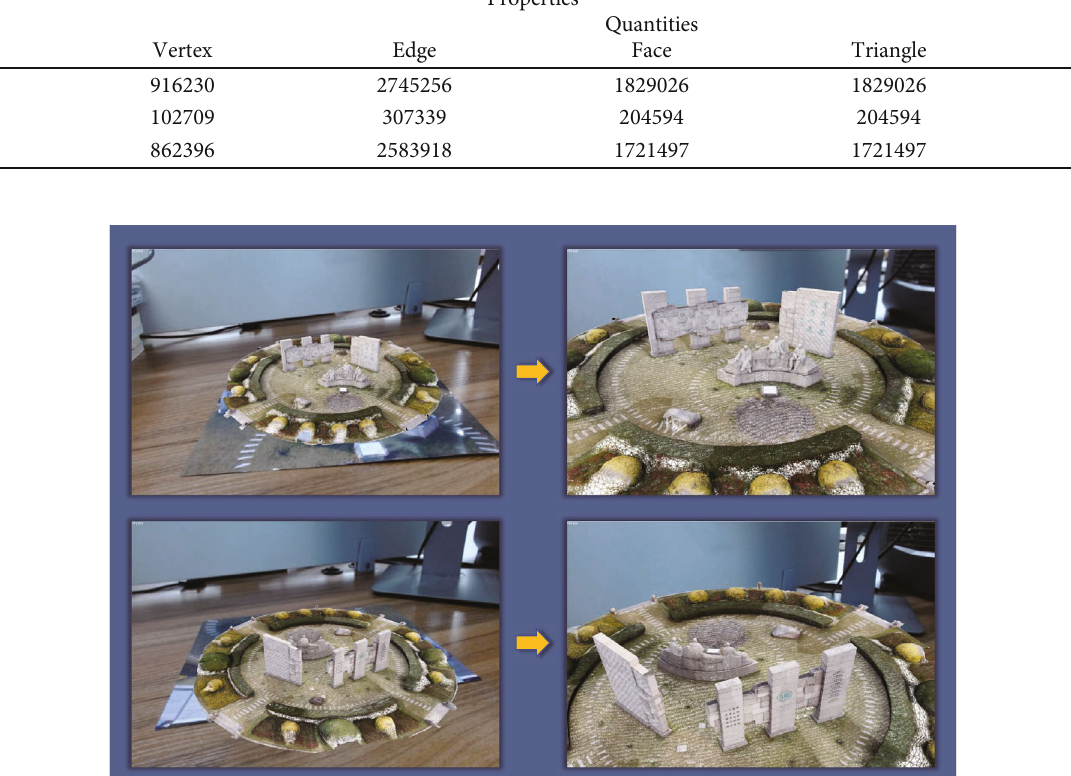
Figure 11: The e ff ect of the change in size of the fused